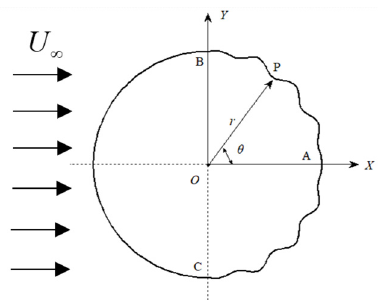
Figure 1. Schematic of fixed circular cylinder with TWW.